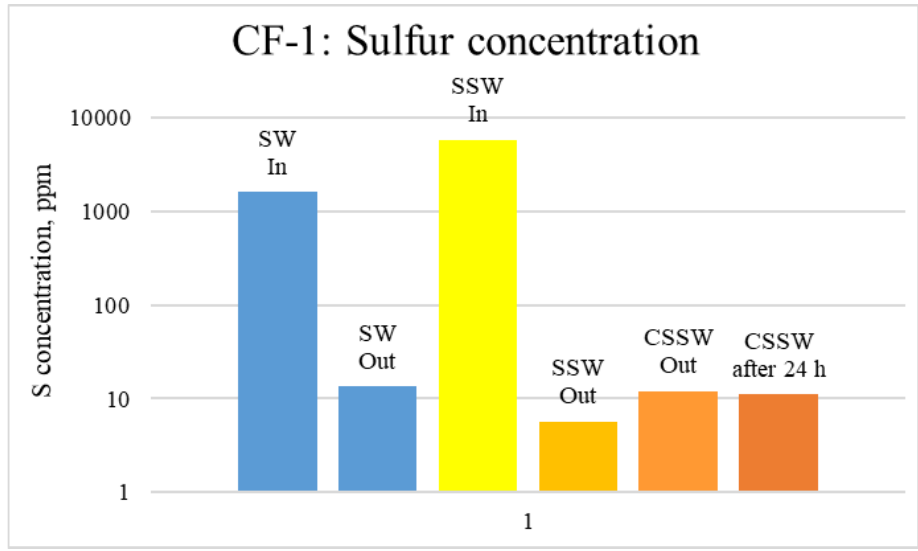
Figure 13. ICP analysis of CF1 brines: Magnesium concentration.